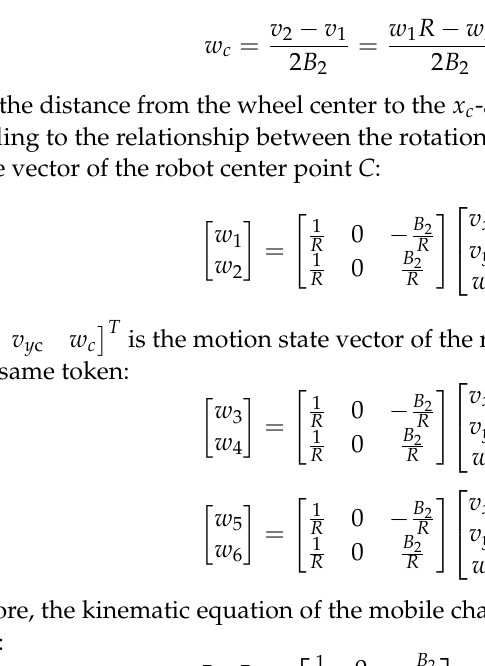
Figure 5. Schematic diagram of ( a ) motion parameters and ( b ) kinematic model of the mobile chassis. The rotational angular speed of the chassis